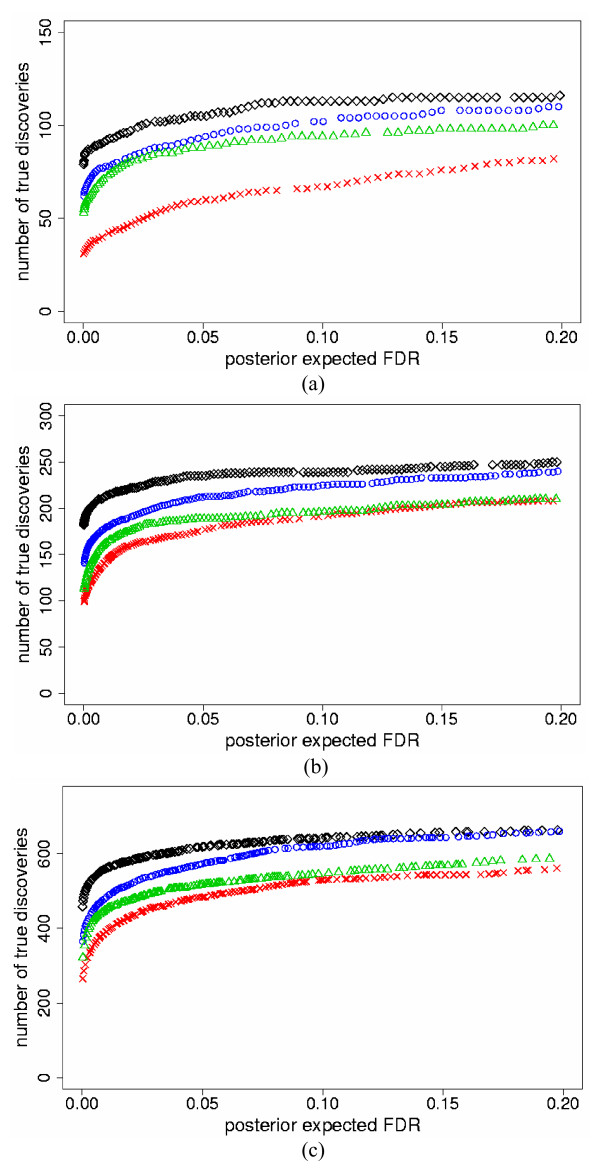
Number of true discovered genes versus peFDR for the two-study simulation data. The maximum number of true discovered genes versus posterior expected false discovery rate (peFDR) for the standardized expression integration model (blue circles), probability integration model (black diamonds), individual analyses of Study 1 (red checks) and Study 2 (green triangles), for the two-study simulation data with high mean τg2
 MathType@MTEF@5@5@+=feaafiart1ev1aaatCvAUfKttLearuWrP9MDH5MBPbIqV92AaeXatLxBI9gBaebbnrfifHhDYfgasaacH8akY=wiFfYdH8Gipec8Eeeu0xXdbba9frFj0=OqFfea0dXdd9vqai=hGuQ8kuc9pgc9s8qqaq=dirpe0xb9q8qiLsFr0=vr0=vr0dc8meaabaqaciaacaGaaeqabaqabeGadaaakeaaiiGacqWFepaDdaqhaaWcbaGaem4zaCgabaGaeGOmaidaaaaa@30EE@ = 0.7 (differentially expressed); 0.07 (non-differentially expressed) and the following simulated percent differentially expressed genes ps: a) 5%; b) 10%; c) 25%.